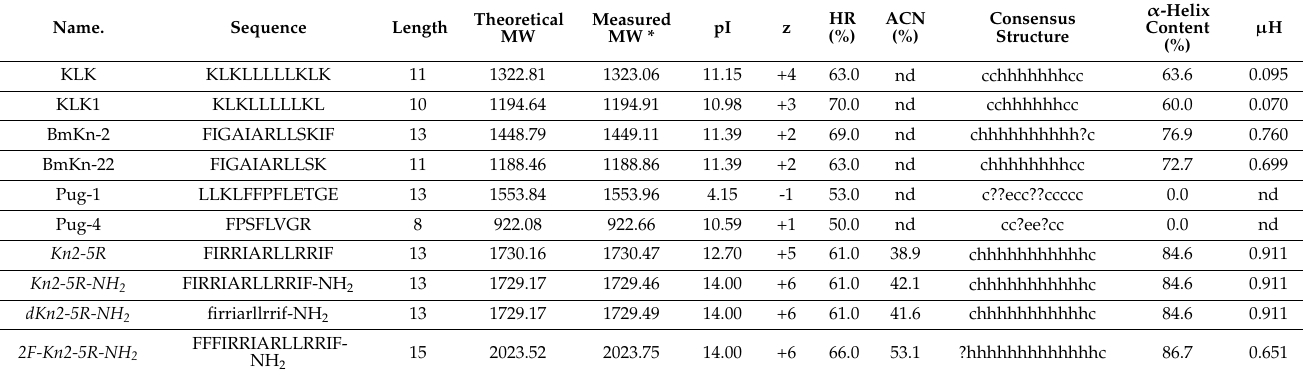
Table 2. Physicochemical properties of peptides and variants designed in this